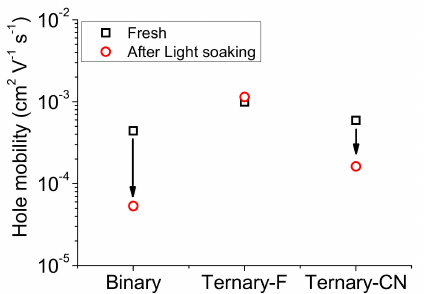
Figure 9. Changes in the hole mobility for Binary, Ternary-F, and Ternary-CN after light